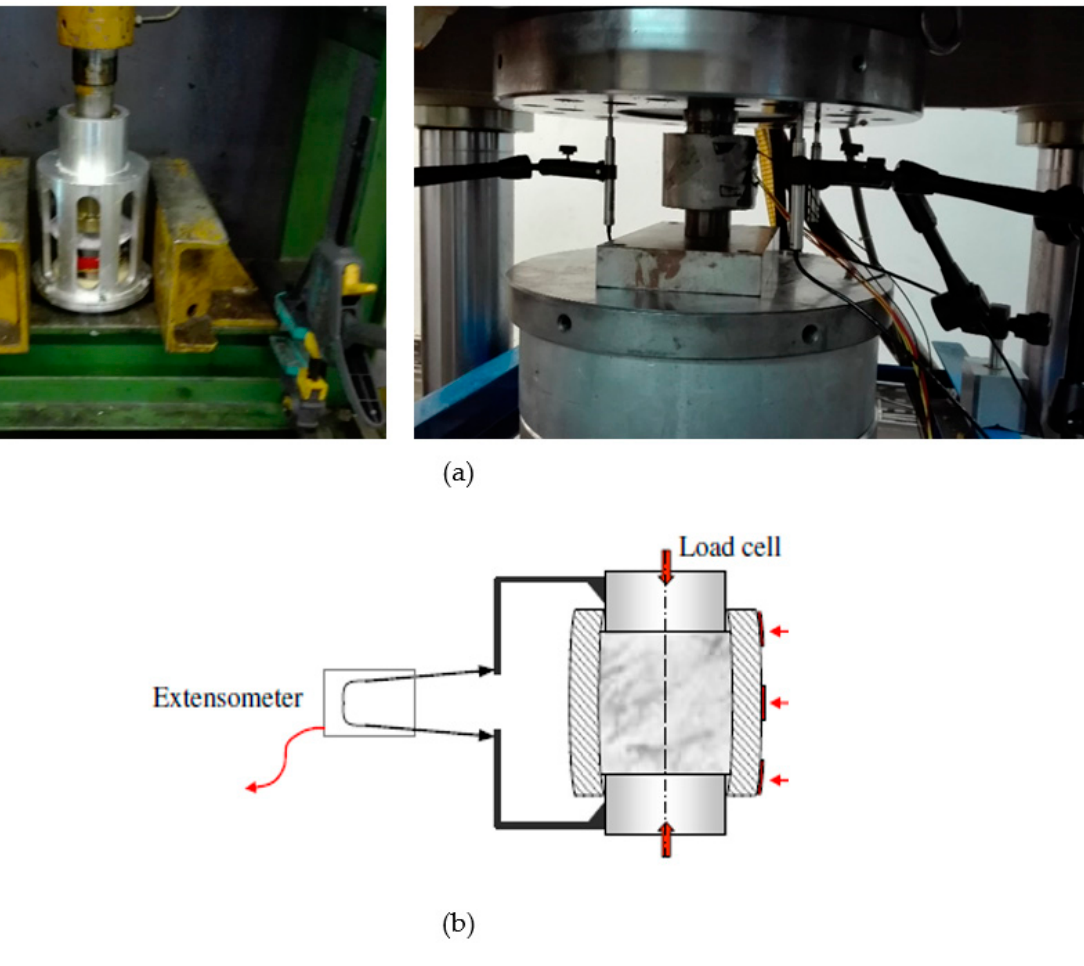
Figure 8. Quasioedometric compression testing method. ( a ) Experimental set-up. ( b ) Scheme of the instrumentation.